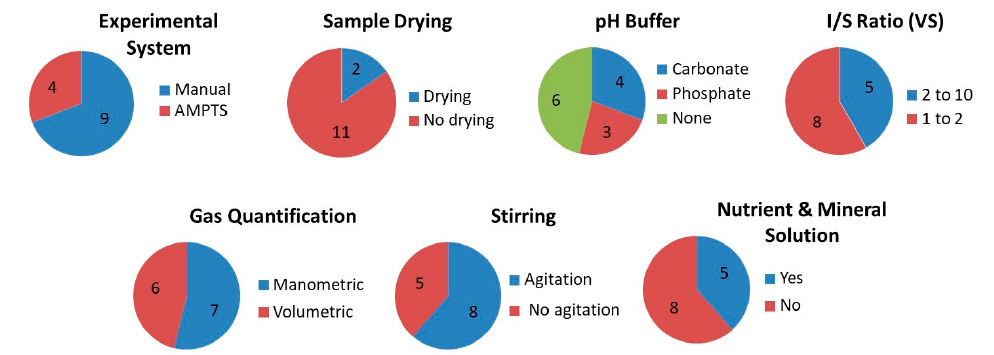
Figure 3. Overview of the existing experimental practices among the lab protocols, for the first phase of the inter-laboratory study. Numbers refer to the 13 lab results.